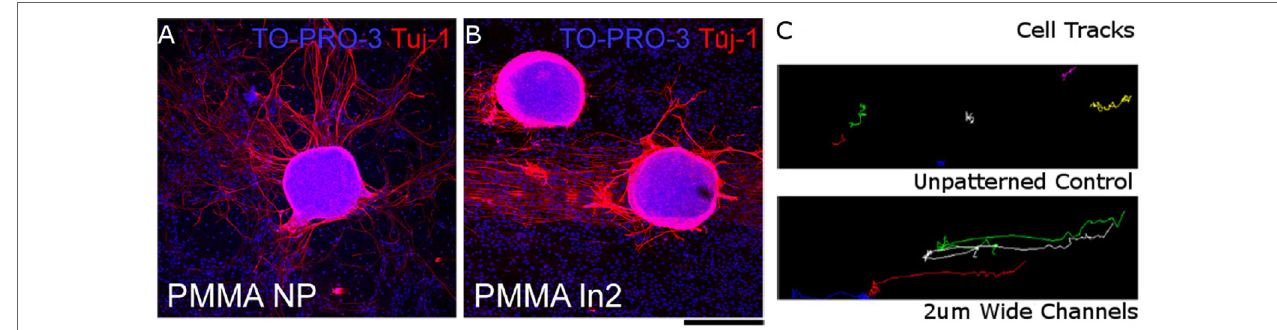
FiGURe 3 | Radial glial cells seeded on (A) unpatterned PMMA surface and (B) PMMA surface with 2-µm wide channels. Cell nuclei stained with TO-PRO-S (blue) and neurons stained with beta tubulin III (red). (C) Particle tracks of neuronal trajectories over 3 h in unpatterned PMMA (top) and PMMA with 2-µm wide channels (bottom). Scale bar = 200 µm. Reproduced with permission of Mattotti et al. (2012), Copyright 2012,